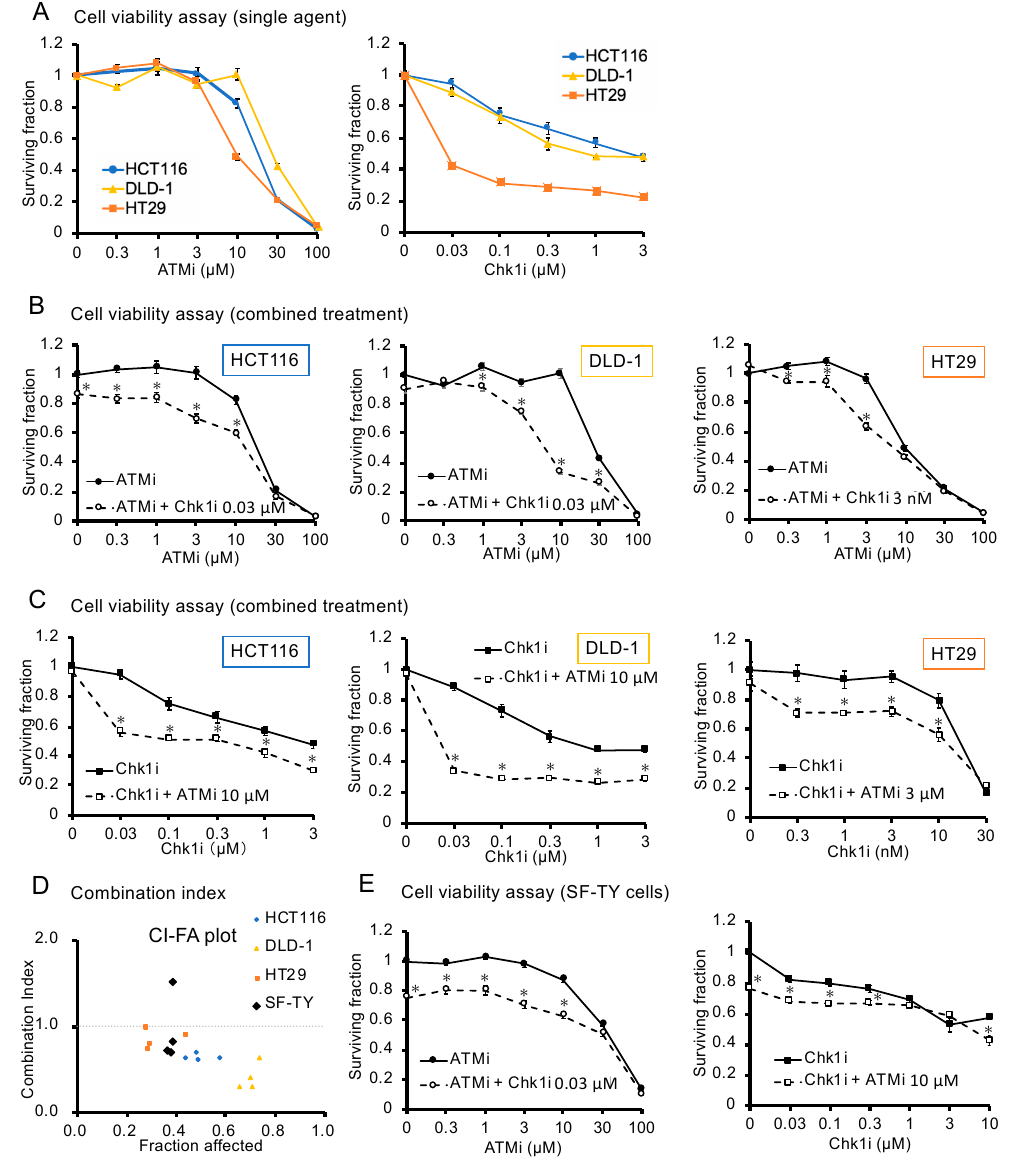
Figure 1. Analysis of the antitumor effect of the ATMi and Chk1i combination. ( A ) Evaluation of the cytotoxicity of the ATMi and Chk1i after 48 h of treatment, as determined using the WST assay. The viability of the untreated cells was defined as 1. Data are presented as mean ± SE ( n = 5). ( B , C ) Effect of the combined ATMi and Chk1i treatment on HCT116, DLD-1, HT29, and SF-TY cells evaluated after 48 h using the WST assay. The viability of the untreated cells was defined as 1. Data are presented as mean ± SE ( n = 5; * p < 0.05; Tukey’s multiple comparison test). ( D ) Combination index (CI) values for HCT116, DLD-1, HT29, and SF-TY cells were calculated based on the WST assay results and are shown in the graph with fraction affected (FA), where a CI < 1 indicates a synergistic effect, CI = 1 indicates an additive effect, and CI > 1 indicates an antagonistic effect. ( E ) Effect of the combined ATMi and Chk1i treatment on SF-TY cells evaluated after 48 h using the WST assay. The viability of the untreated cells was defined as 1. Data are presented as mean ± SE ( n = 5; * p < 0.05 compared to single drug stimulation group).